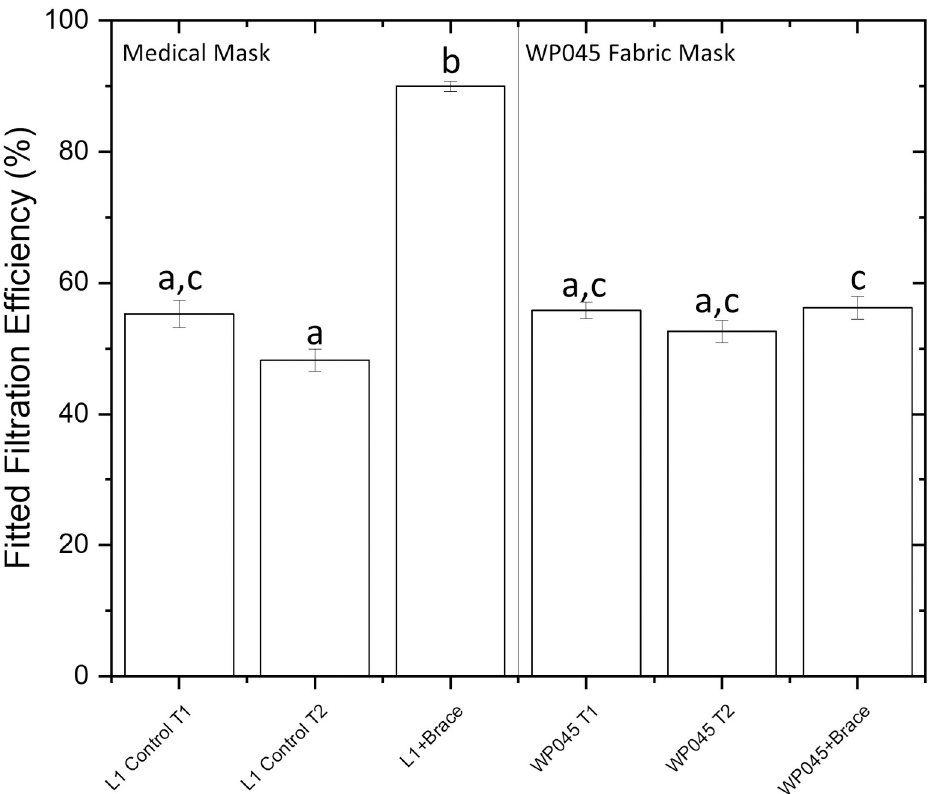
Fig 6. Fitted filtration efficiencies with and without a mask fitter. Column descriptors T1 and T2 refer to Tester #1 and Tester #2. L1 control refers to the L1 medical mask donned with ear loops, L1 + Fitter is the medical mask worn with a mask fitter, WP045 is a high quality quilting cotton mask donned with fabric ties and WP045 + Fitter is the same mask worn with a mask fitter. Bars with different letters are significantly different from one another (p < 0.05; Tukey’s pairwise comparisons